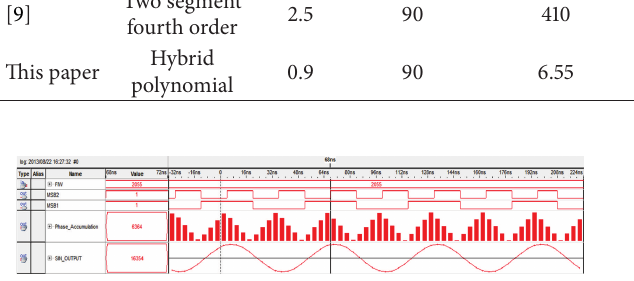
Figure 17: Signals Tap output